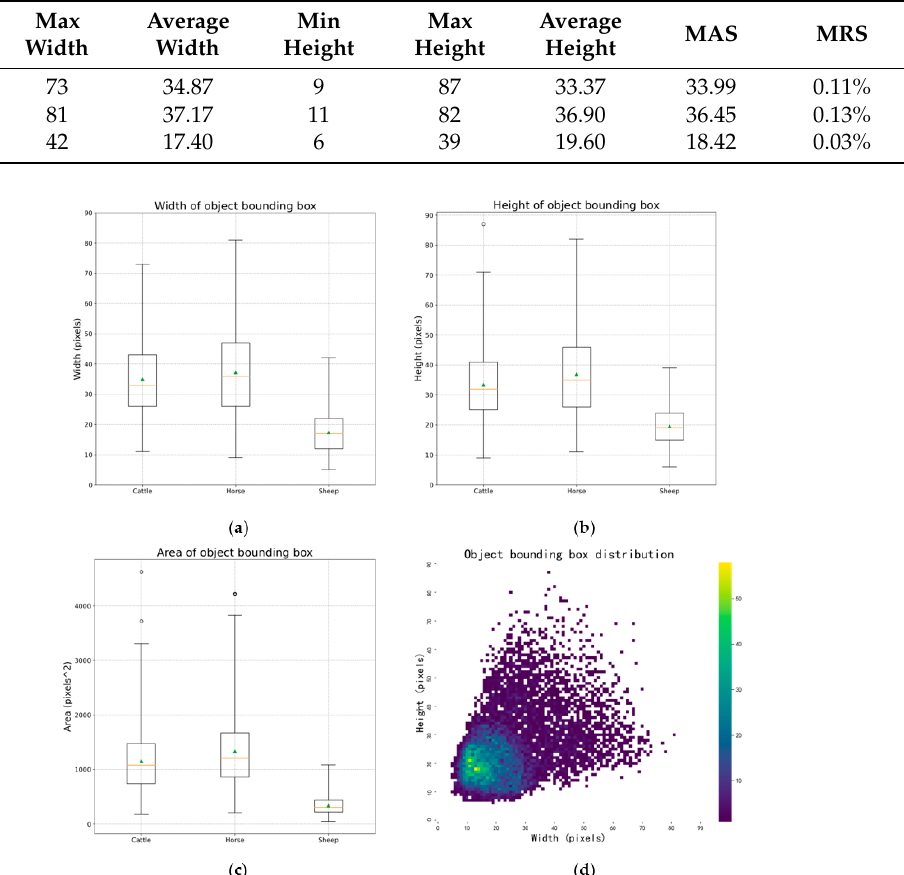
Figure 5. ( a ) The boxplot of object bounding box width. ( b ) The boxplot of object bounding box height. ( c ) The boxplot of object bounding box area. ( d ) The distribution of the object bounding boxes in the dataset. The horizontal axis is the width of the object bounding boxes and the vertical axis is the height. The color represents the number of boxes with the width and height in the coordinate system.